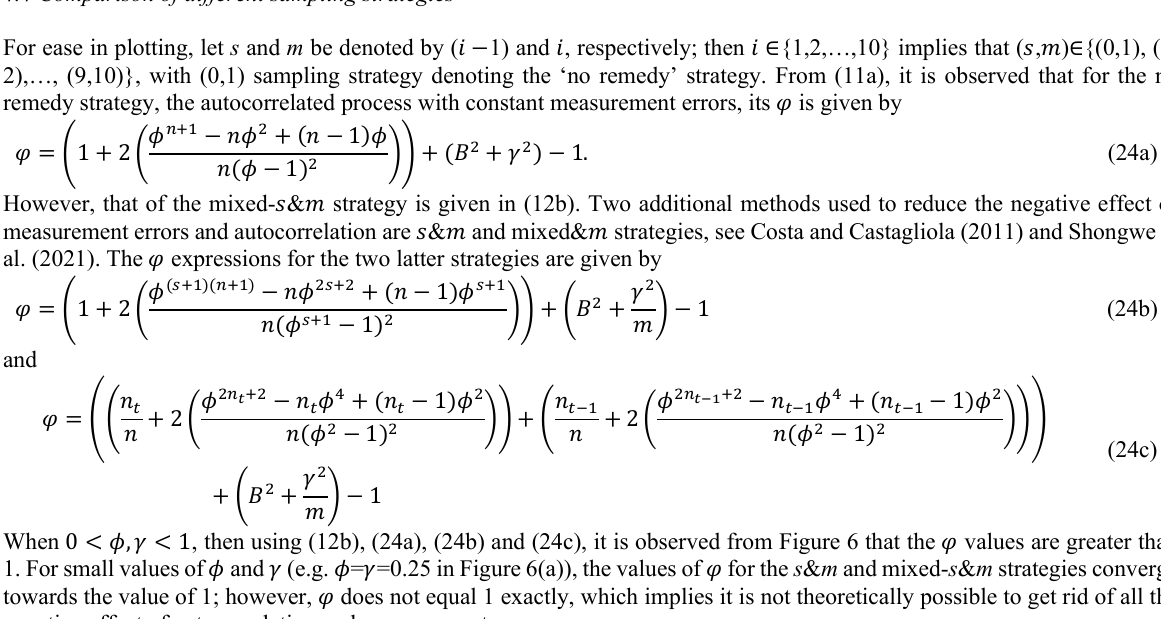
Fig. 4. The 𝐴𝑅𝐿 profiles of the HWMA 𝑋(cid:3364) ∗ scheme (for the mixed-3&4 strategy) with a linearly increasing variance when 𝐷 =0, 𝐶 ∈ {1,2,3} 𝑛 =5, 𝜆 =0.1, 𝜙 =0.75, 𝐿 ∗ =2.938 and =500 𝐴𝑅𝐿 (cid:2868)